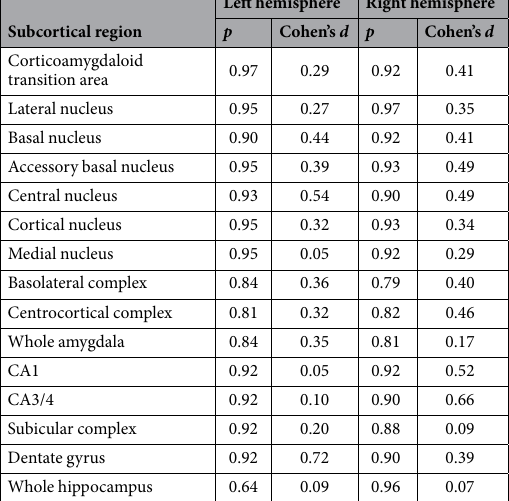
Table 1. Between group statistical analysis results for amygdala nuclei, whole amygdala, hippocampal subfields and whole hippocampus